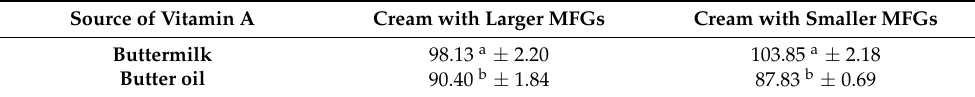
Table 6. Concentration of retinol in larger and smaller MFGs (obtained from the same cream) expressed as % retinol/g of fat of buttermilk or butter oil compared with retinol content in whole milk. Data are expressed as mean ± SEM. Values with different superscripts ( a,b ) are significantly different ( p < 0.05). Data from Zahar and Smith (1995)